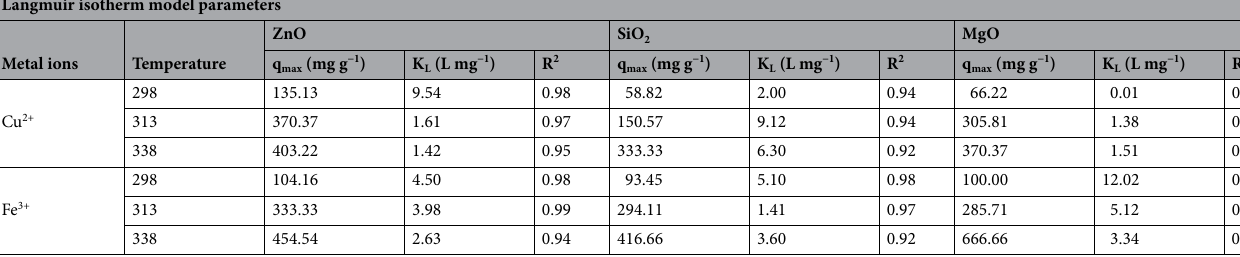
Table 3. Langmuir isotherm model parameters and correlation coefficients for the adsorption of Cu 2+ and Fe 3+ on ZnO, SiO 2 , and MgO NPs.